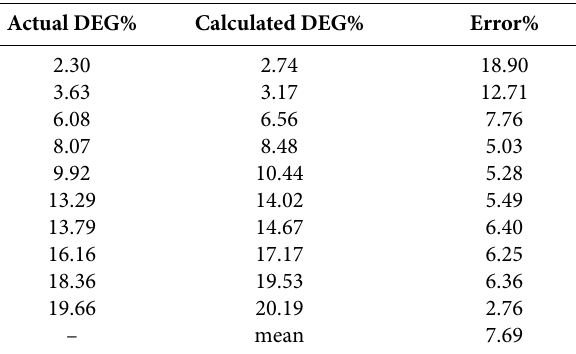
Table 5: Actual and predicted DEG percentages from corrected ab- sorbance at 881 cm –1 for Lemon Balm Extract Actual DEG%